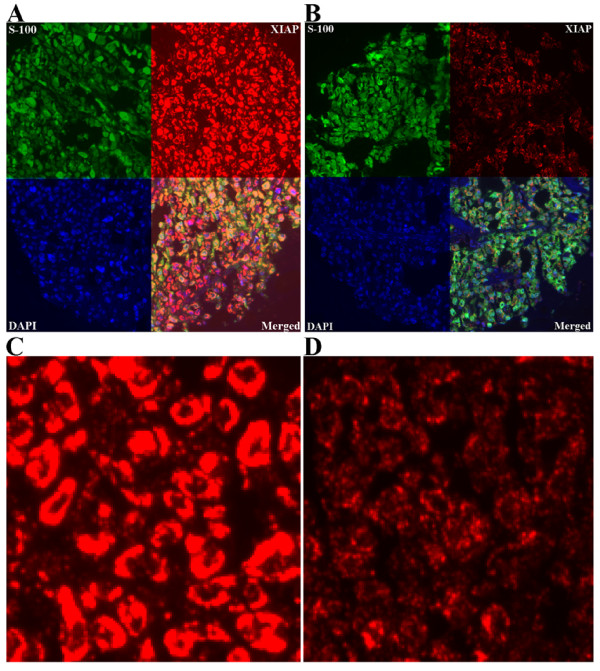
Strong (A) and weak (B) XIAP expression (red) in melanoma using ×10 magnification, employing S100 (green) to define tumor and DAPI (blue) to define nuclei. Strong (C) and weak (D) XIAP expression are shown using ×60 magnification. The strong spot corresponds to an AQUA score of 52.91 and the weak spot to a score of 21.85.